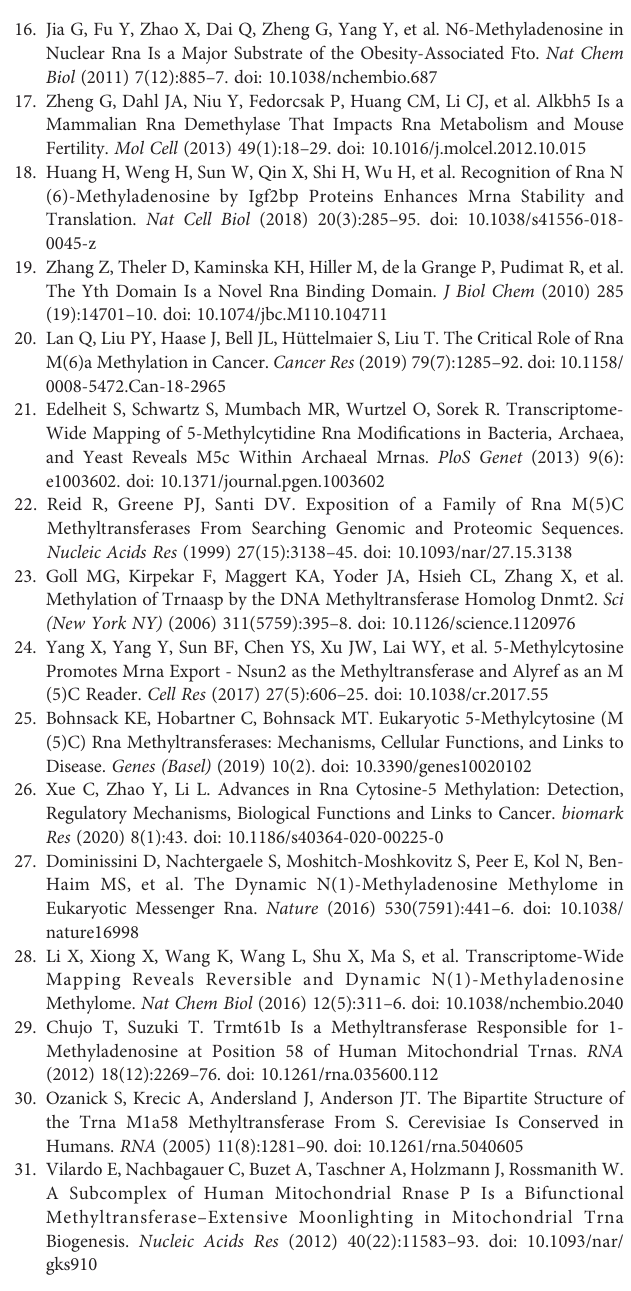
pathway enrichment among distinct Regulator gene subtypes. (I) The in fi ltration of immune cells within distinct Regulator gene subtypes. (J) Scatter plots depicting the positive correlation between TMB and Regulator Score in TCGA- SARC cohort. Supplementary Figure 6 | Validation and subgroup analysis of Regulator Score. (A) Differences of Regulator Score among distinct Regulator Clusters. (B, C) Time-dependent ROC evaluating the predictive performance of Regulator Score in GSE17674 (B) and GSE30929 (C) . (D – N) Subgroup analysis of Regulator Scores in different clinical characteristics groups including age, gender, site and